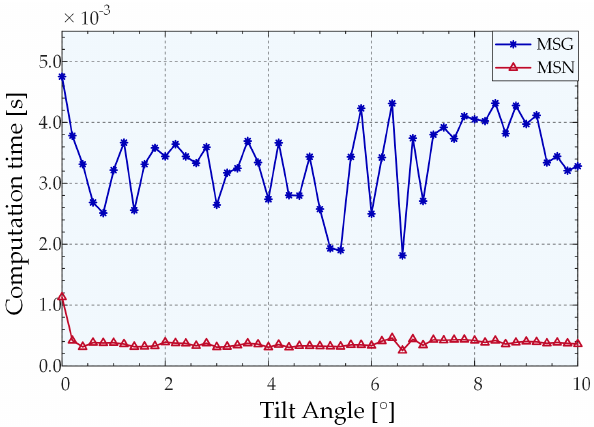
Figure 9. Comparison of the average processing times of MSG and MSN.